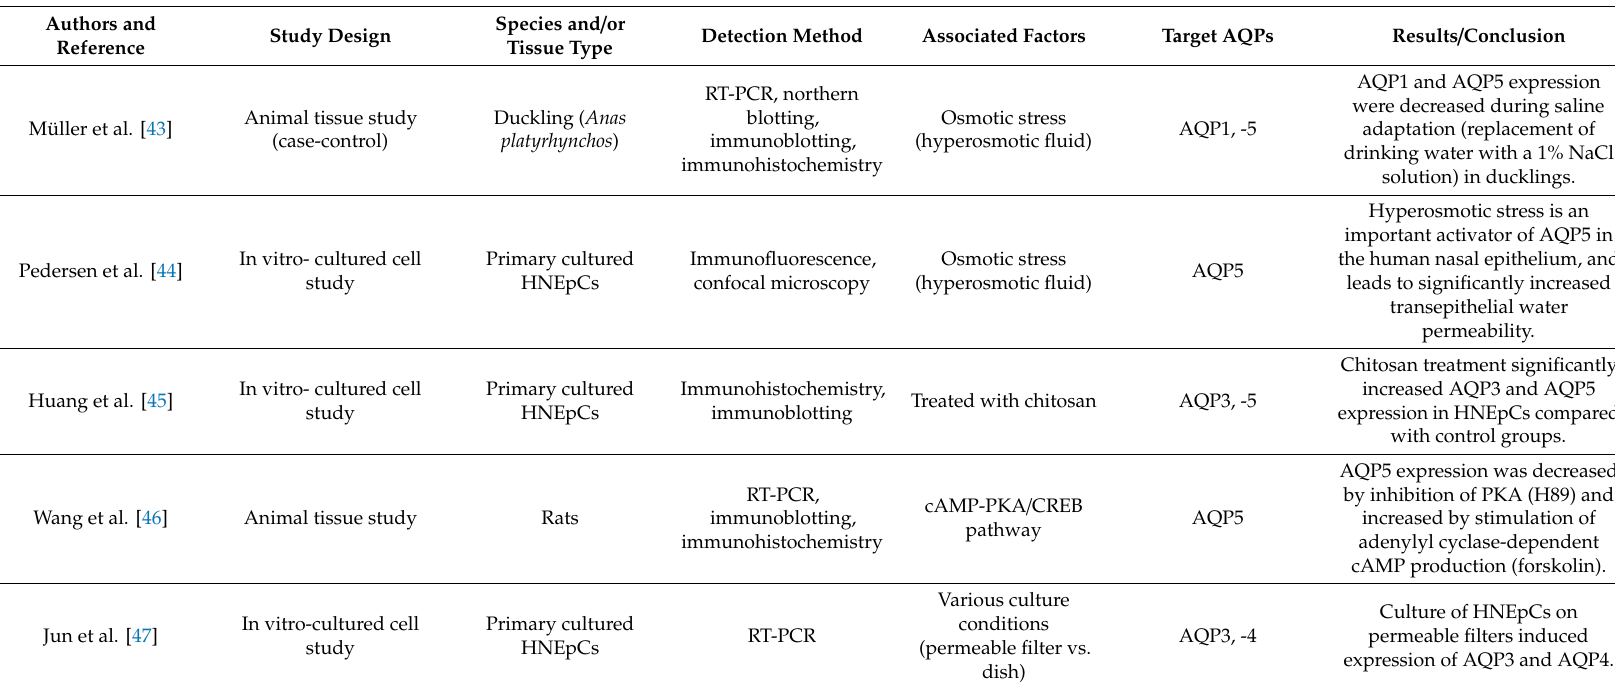
Table 2. Studies assessing the factors that regulate the expression of AQPs in the respiratory epithelium of the nasal